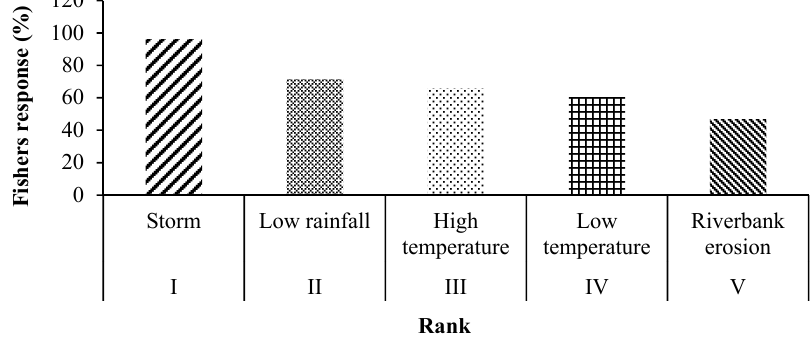
Figure 3. Rank of the climatic hazards and disasters based on their impacts on the livelihoods of migratory and non-migratory fishers of the Padma River, Bangladesh.